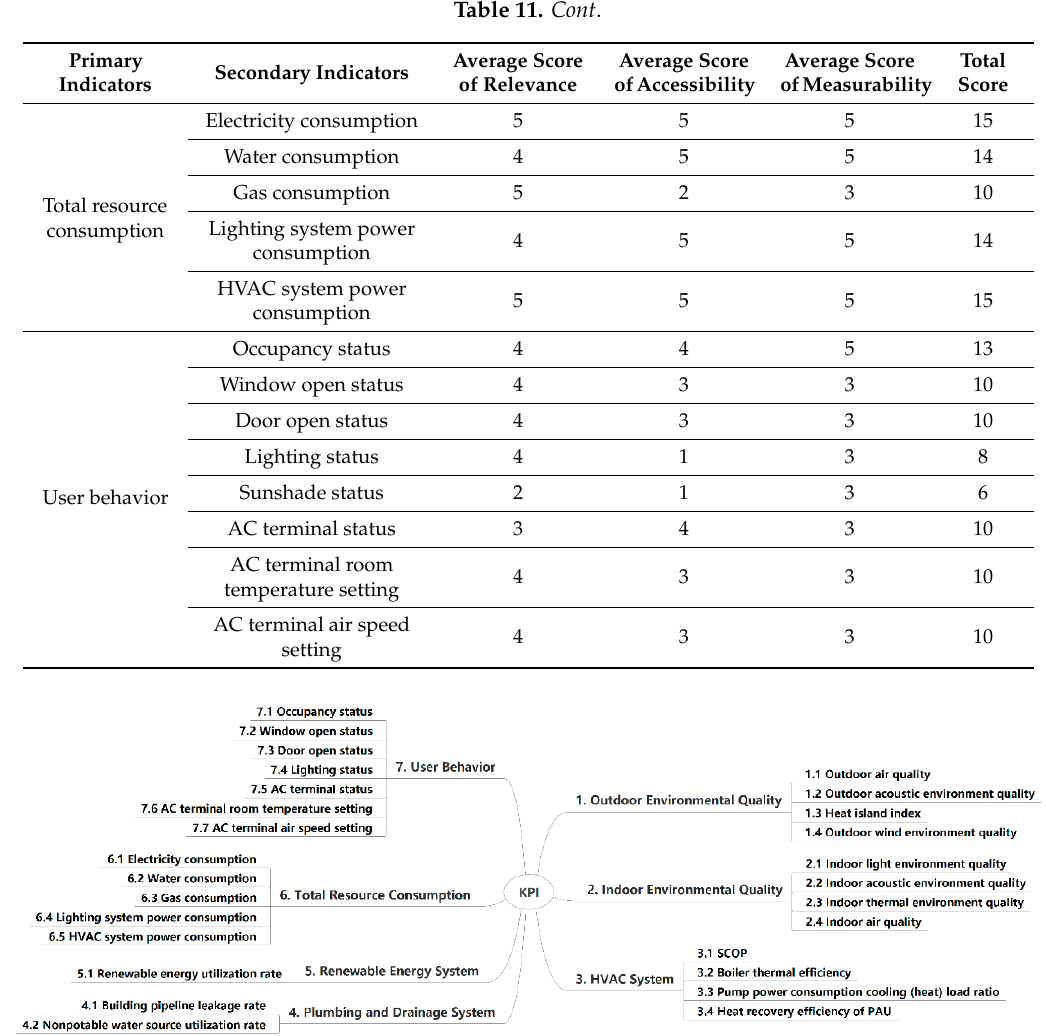
Figure 4. Key Performance Indicators (KPIs) for green building operations monitoring.